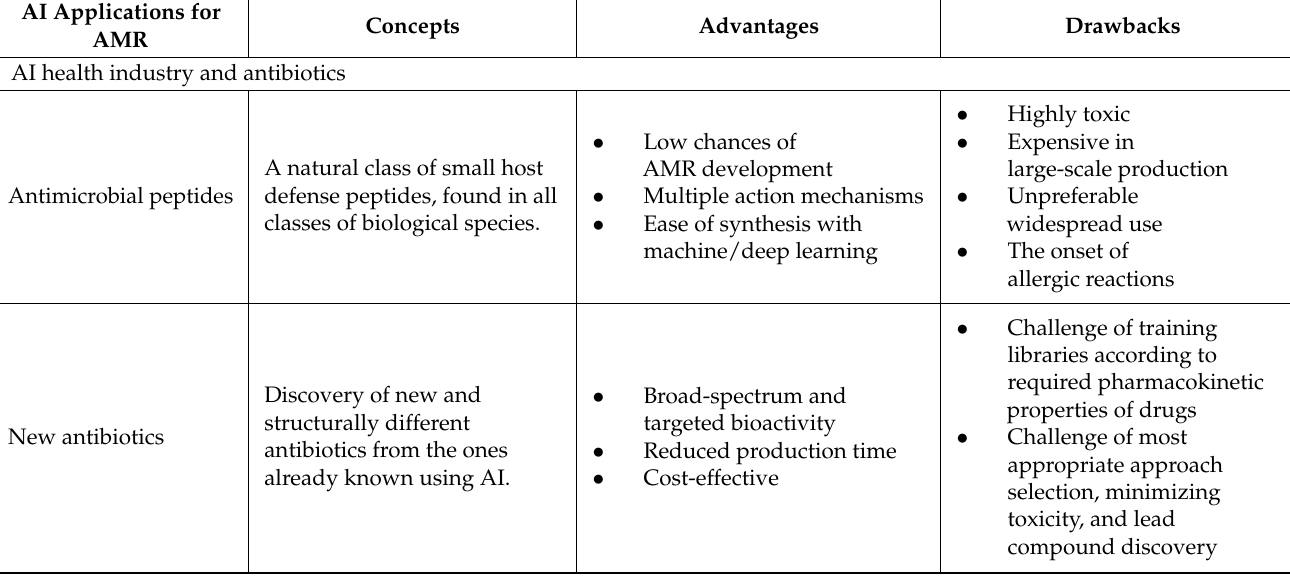
Table 1. AI application strategies against